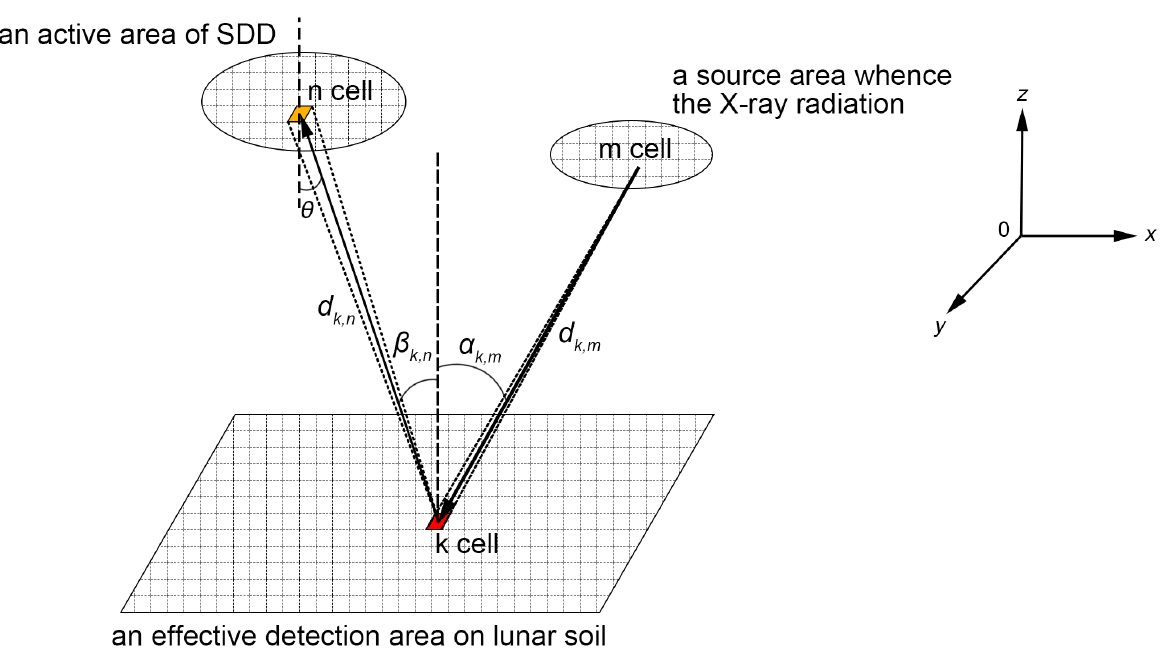
Figure 7. Illustration of geometrical decomposition for APXS. Table 8. Summary of the definitions of parameters in the function of detection